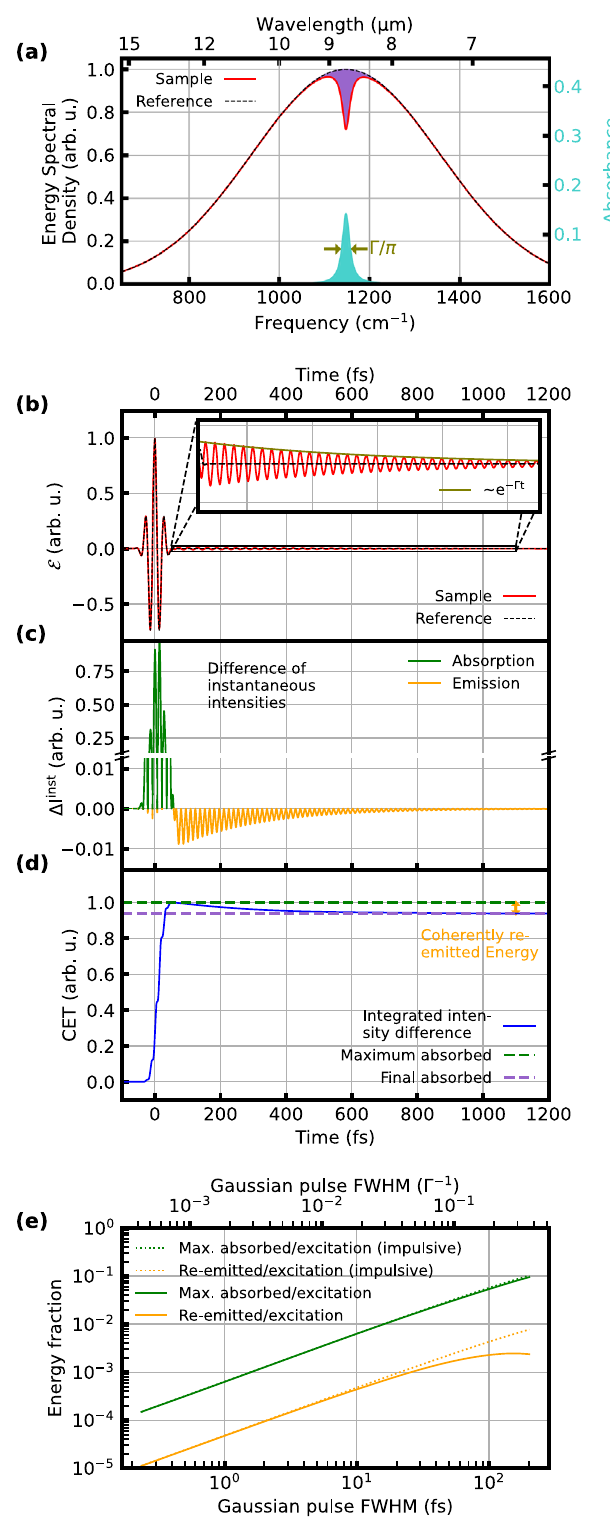
Fig. 1 | Time-integrated and time-resolved broadband vibrational spectro- scopy. a Model spectrum before (black, dashed) and after (red) transmission through a Lorentzian absorber centered at 1148cm − 1 with a full-width-at-half-max- imum (FWHM, Γ / π ) of 19.4cm − 1 , shown for conventional (time-integrating) absorption spectroscopy. Purpleshadedarea:difference between the twospectra, amounting to the energy incoherently dissipated in the molecular sample. Tur- quoiseshadedarea:normalizedabsorbance,de fi nedasthedifferencebetweenthe logarithms of the two spectra log 10 ð ∣ Reference ∣ Þ(cid:2) log 10 ð ∣ Sample ∣ Þ . b Electric fi eld E ð t Þ ofthe30-fs-full-width-half-maximumGaussianexcitationpulse(black,dashed) with the spectrum shown in black in a . Red: coherent response of the Lorentzian absorbershownin a tothisfew-cycleexcitation(FCE).Olive:decayofthemolecular response due to dephasing proportional to e − Γ t . c Time-resolved difference Δ I inst ( t )oftheinstantaneousintensitiesoftheelectric fi eldsin b .Thepositivevalues (green) correspond to absorption, the negative values (yellow) to coherent emis- sion.ForFCE,thecoherentemissioneventhasnocontributionfromtheexcitation. d Integration of Δ I inst ( t ) shown in c yields the coherent energy transfer CET( t ). Green dashed line: maximum of CET( t ), i.e., the maximum transiently absorbed energy.Purpledashedline:endvalueofCET( t ),equaltothepurpleshadedareain a . Orangedoublearrow:differencebetweenmaximumandendvalue,corresponding totheenergywhichiscoherently re-emittedbytheLorentzianabsorber. e Ratioof the maximum transiently absorbed energy (green) and the coherently-re-emitted energy (yellow) to the excitation pulse energy, as a function of the FCE-pulse duration. These ratios deviate by less than 30% from the values for the impulsive excitation regime (dotted lines, see also Supplementary Information) for pulse durations below one-tenth of the typical Lorentzian decay time Γ -1 (here,